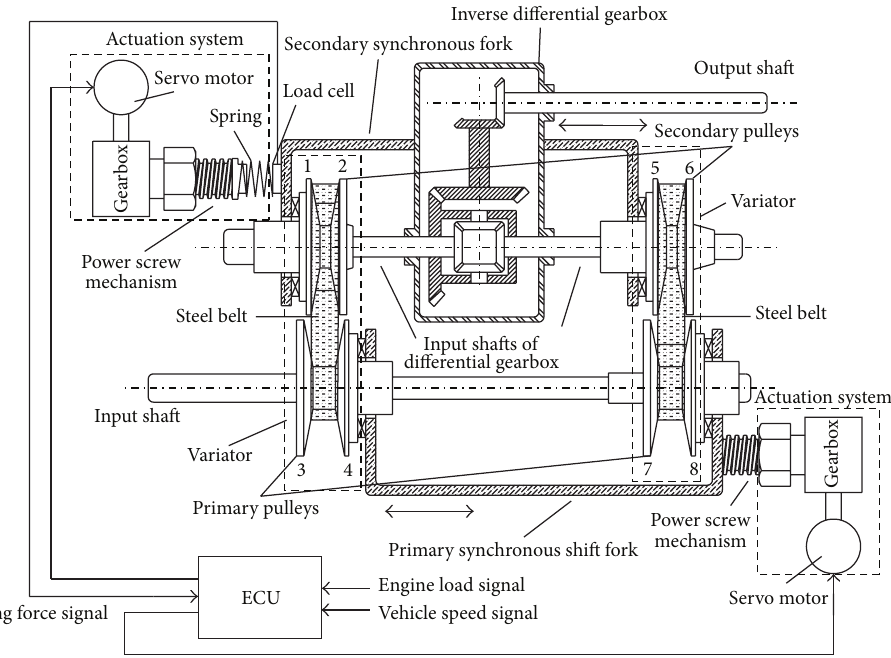
Figure 3: Schematic design of